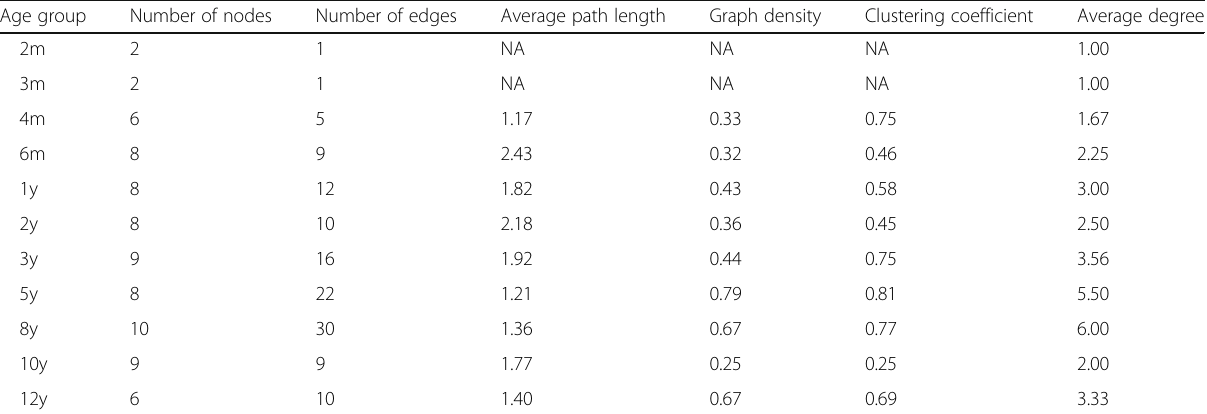
Table 2 Global topological properties of co-occurring networks of intra-interactions in each microbial kingdom (Continued) Age